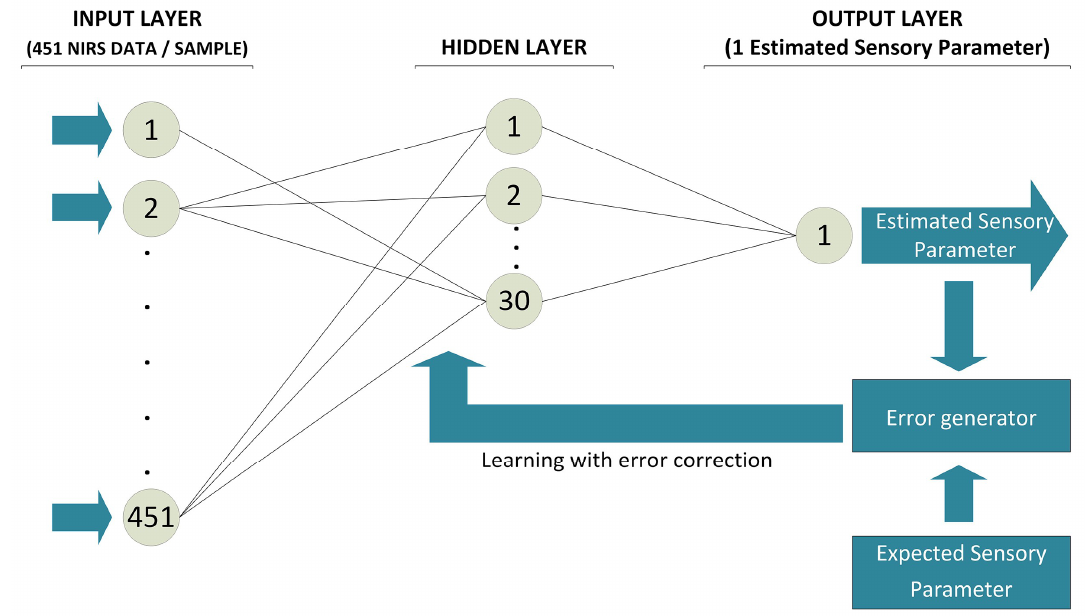
Figure 2. Sensors 2020 , 20 , x FOR PEER REVIEW